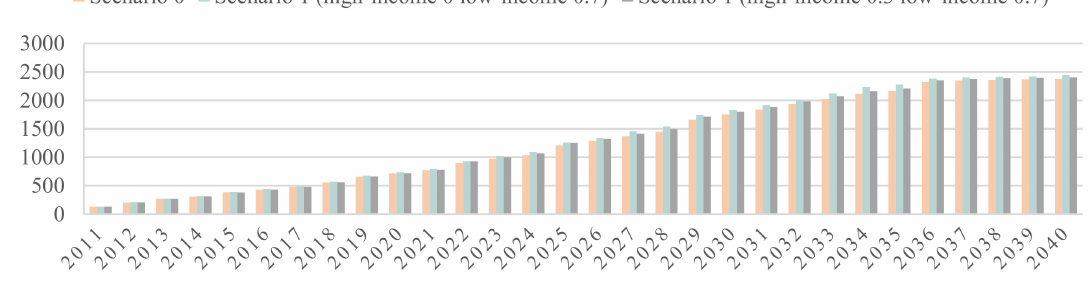
Figure 7. Comparison between Scenario 0 and Scenario 1.